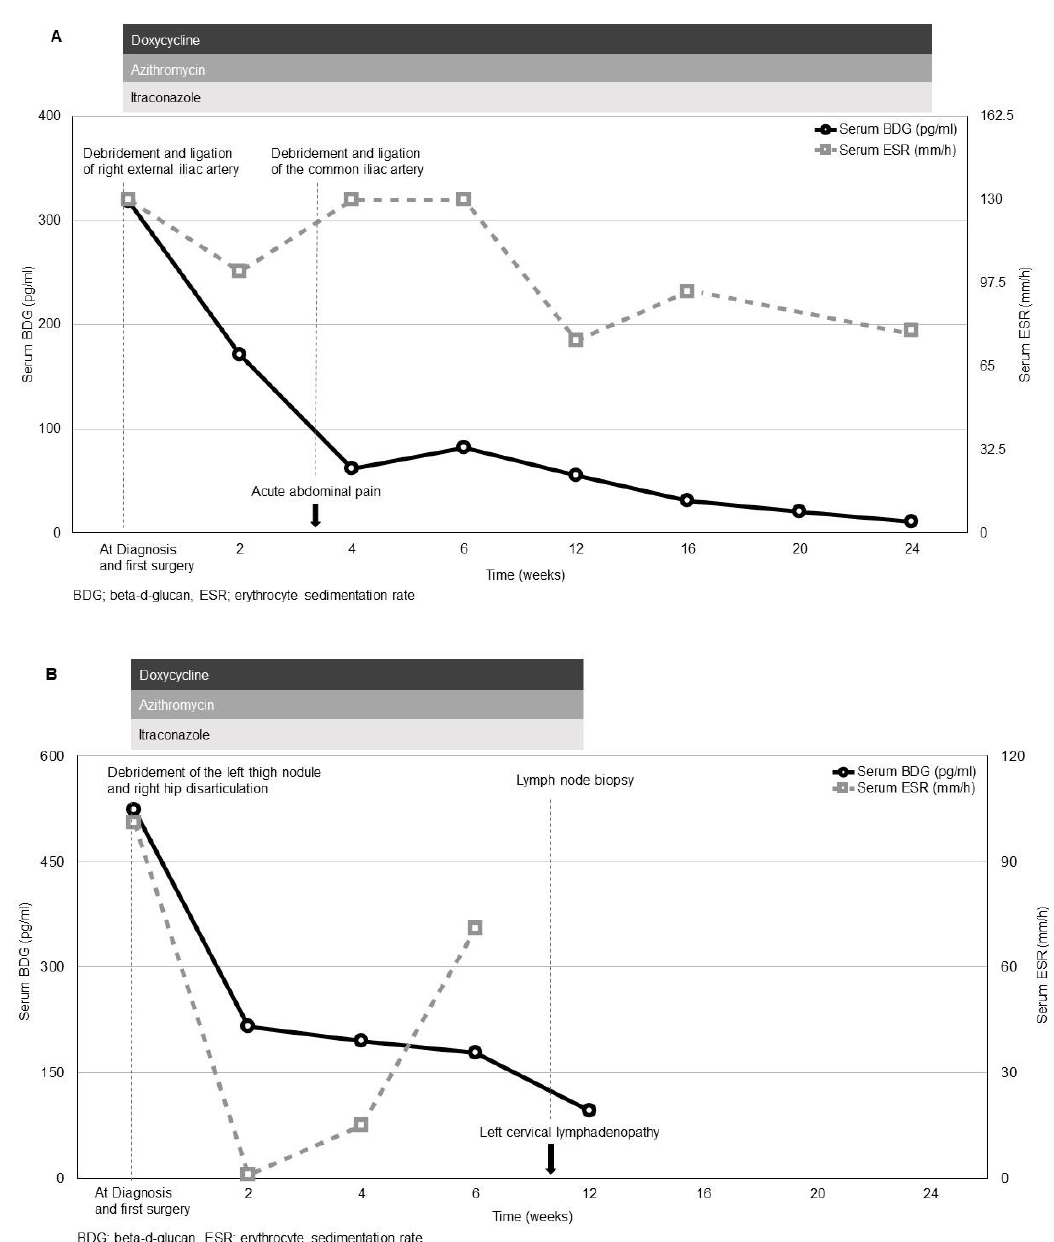
Figure 2. Clinical course and treatment modalities of relapsed disease ( A ) and disseminated disease ( B ). In case 9, serum BDG, ESR, and CRP initially declined after initial treatment (right hip disarticulation, wide excision of the subcutaneous nodule at the left thigh and antimicrobial therapy with itraconazole, azithromycin and doxycycline). The patient was diagnosed with disseminated pythiosis given presence of fungal elements from the right lower extremity vessels and from the skin lesion on the left thigh. Microscopic examination of the vascular tissue by using 10% potassium hydroxide preparation showed scarcely septate hyphae consistent with P. insidiosum (Figure 3). Computed tomography angiography at the time of diagnosis did not reveal disease involvement of the left lower extremity vessels. Prognosis was thoroughly discussed, and the patient elected to continue only medical therapy. Subsequent serum BDG, ESR, and CRP remained significantly elevated. Unfortunately, the patient developed left neck swelling and the lymph node biopsy showed fungal element consistent with P. insidiosum. Case 9 died at 5 months after initial diagnosis (Figure